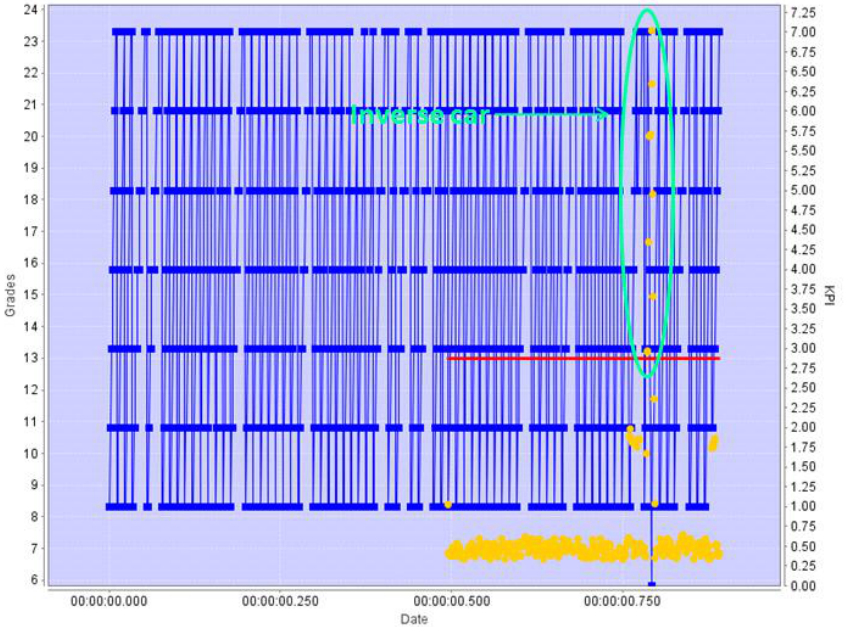
Figure 9. A car driving in the wrong direction, a change in the pattern of direction of movement is detected, even before car completed the full change of direction. The grades referred to the directional KPI indicates a new pattern of the direction